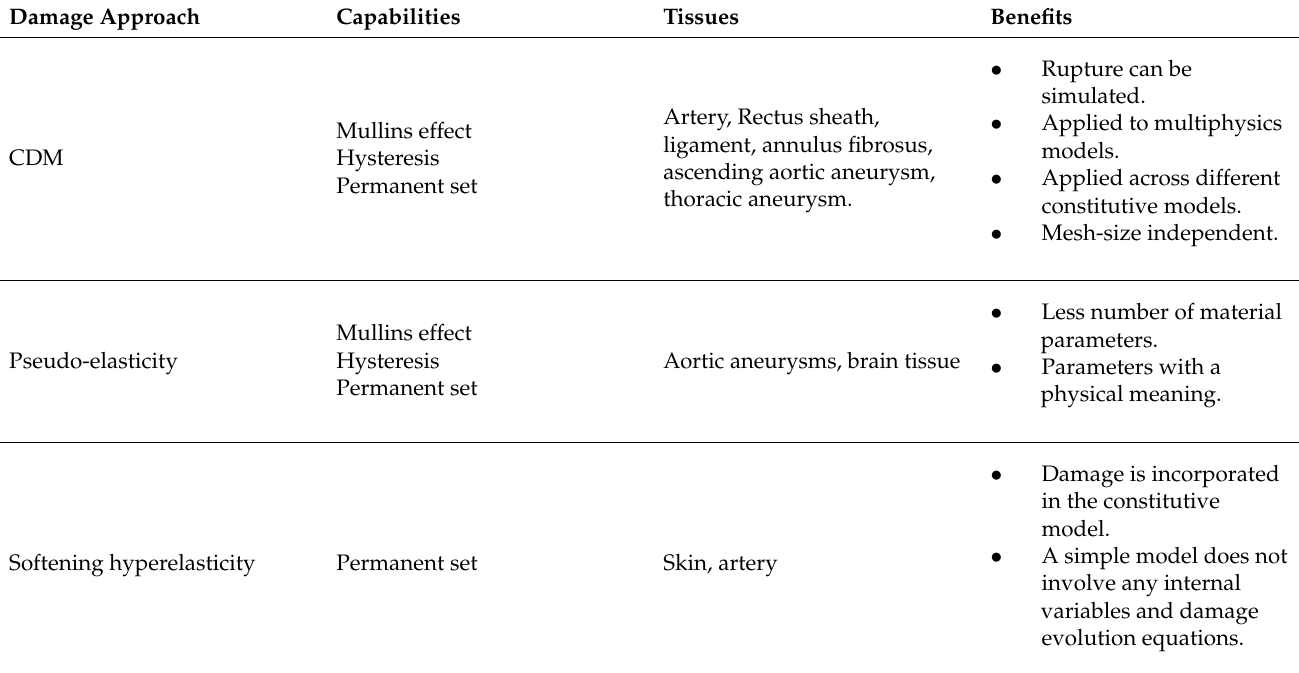
Table 3. Summary of damage modelling